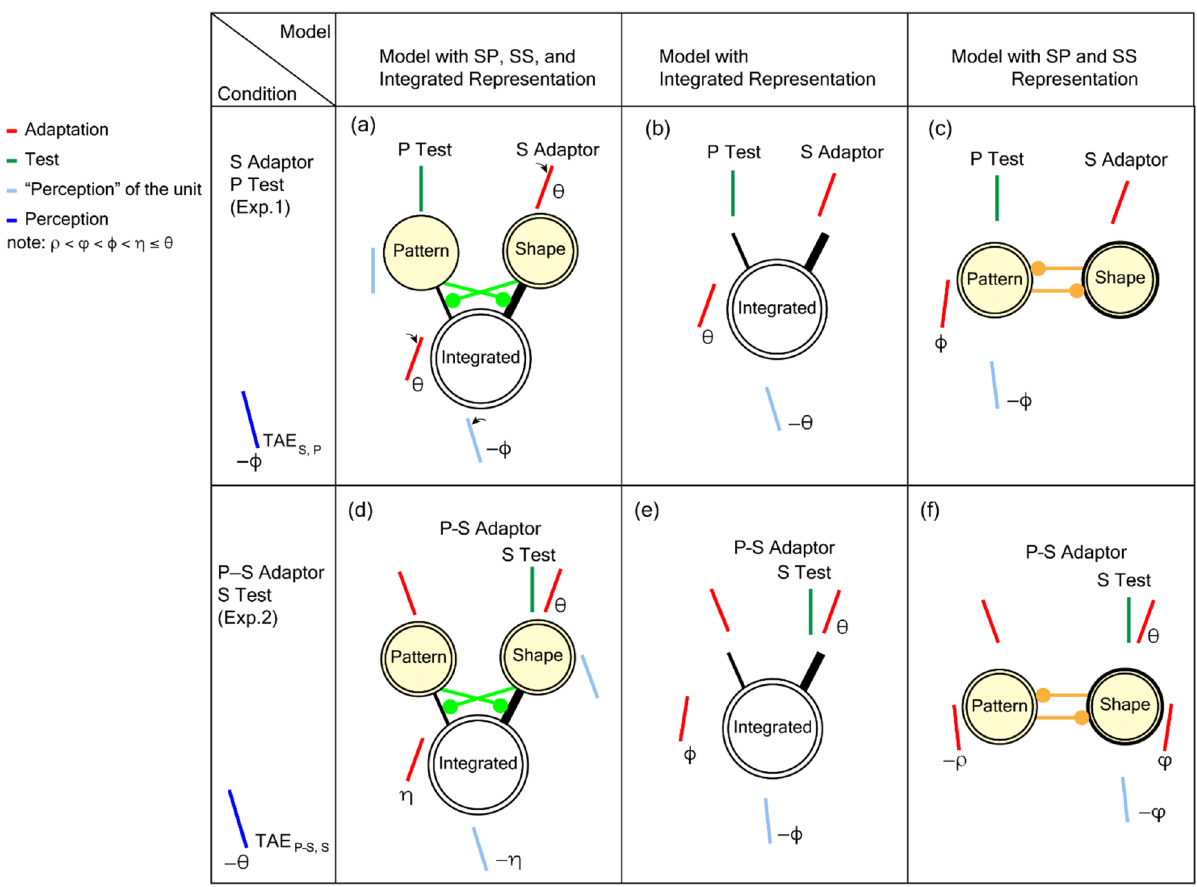
Figure 6. A comparison of the conceptual model. The left column (panels a , d ) indicates the behavior of the proposed model with the independent representations of SP and SS, followed by the integrated representation, as indicated by "Pattern", "Shape", and "Integrated", respectively. The double circles indicate that these circuitries were adapted. The center column (panels b , e ) indicates an alternative model with the integrated representation but without independent pattern and shape representations. The right column ( c , f ) indicates another model comprised of the pattern and shape representations with mutual facilitatory connections. The top row indicates the model responses for the transfer condition with the S adaptor and P test stimulus (TAE S,P ). The bottom row indicates the responses for the incongruent condition with the S test (TAE P–S,S ). Throughout the panels, red and green bars on the top illustrate the tilt of the adaptor and test stimulus, respectively. Red and light-blue bars around the representations illustrate the hypothetical adaptation (i.e., neurons responsive to this tilt are activated and fatigued) for the representation and the resultant TAE expected in the representation, respectively. In the proposed model (panels a , d ), the tilt of the red bar on the top also illustrates adaptation in the shape and pattern representation. Blue lines illustrate the TAE observed in the psychophysical experiments. The thickness of the lines between the representations illustrates the magnitude of influence, and green and yellow denote suppressive and facilitative influence, respectively. Although all three models could reproduce the transfer condition, only the proposed model reproduced the incongruent condition (refer to the main cortical representation that integrates SP and SS. We further investigated the interactions between SP and SS in the adaptation. Antagonistic adaptation, wherein the symmetry axes of SP and SS were tilted in opposite directions, showed subtractive interaction between the two. In contrast, synergic adaptation, wherein the sym- metry axes were tilted in the same direction, showed compressive interaction. These results suggest compressive nonlinearity in the integration; TAEs are processed linearly when single or incongruent adaptors are presented but compressively when congruent adaptors are presented. This nonlinearity is ecologically advantageous, as the overestimation of tilt is avoided; we do not see that the tilt doubles even when SP and SS are congruent. These results support the notion that the neural mechanisms underlying the SS and SP operate independently, followed by the cortical representation that integrates the SP and SS with mutual suppression. The mutual transfer between SP and SS observed in Exp. 1 supports the fact that neural circuitries for process- ing SP and SS operate independently, followed by the representation of “generic symmetry” that integrates SP and SS. We propose a conceptual model comprising the representations of pattern, shape, and their integration with mutual suppression between SP and SS through the formation of the integration, as shown in Fig. 6a. For instance, if the S adaptors were presented with the symmetry axis tilted to θ , the neural circuitry responsible for the shape representation and that responsible for the integrated representation would be activated and fatigued. A group